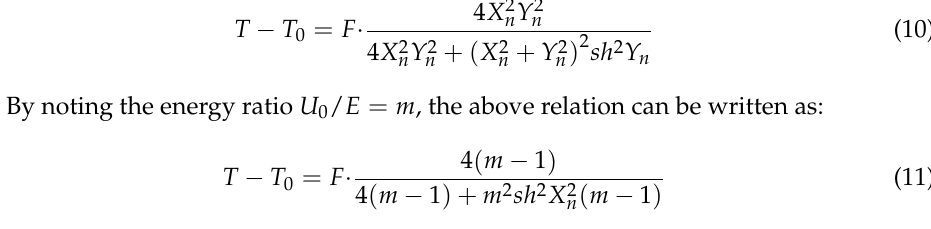
Figure 3. The three-dimensional variation of the multifractal transparency variation ∆ T for time t and energy ratio m , from two different perspectives. Considering one variable constant, the multifractal transparency variation for energy ratio 𝑚 and time 𝑡 , and for 𝑡 (cid:3404) 𝑐𝑜𝑛𝑠𝑡 . and 𝑚 (cid:3404) 𝑐𝑜𝑛𝑠𝑡 . are represented in Figure 4a,b.